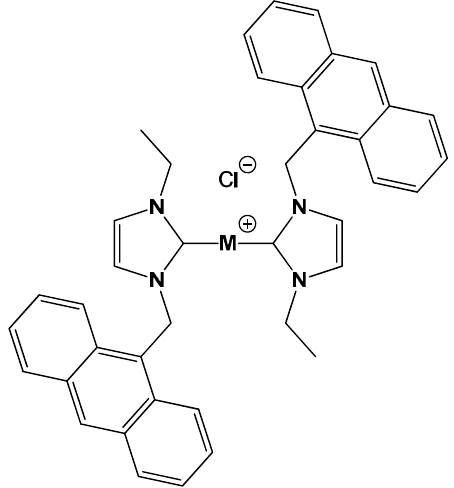
Figure 1. Molecular structure of the M(I)(bis(1-(anthracen-9-ylmethyl)-3-ethylimidazol-2-ylidene) chloride compounds studied: [Ag(EIA) 2 ]Cl and [Au(EIA) 2 ]Cl.